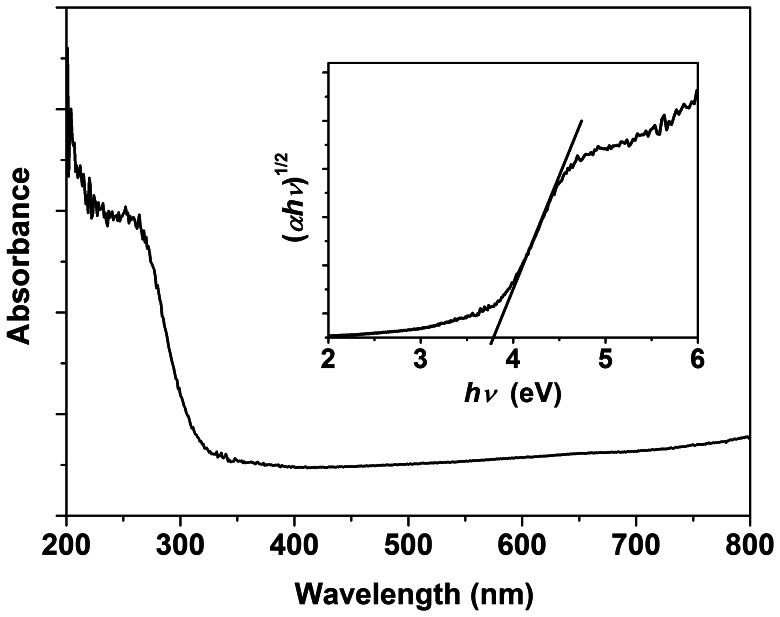
DRS spectrum of the annealed coral-like Ta2O5.The insert is the corresponding variation of (αhv)1/2 vs. hv.